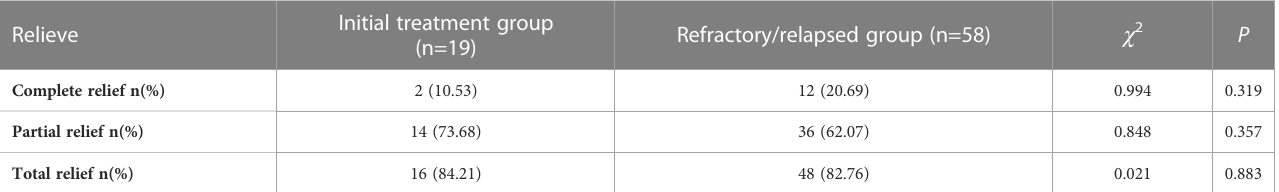
TABLE 4 Comparison of treatment effects between the two groups.